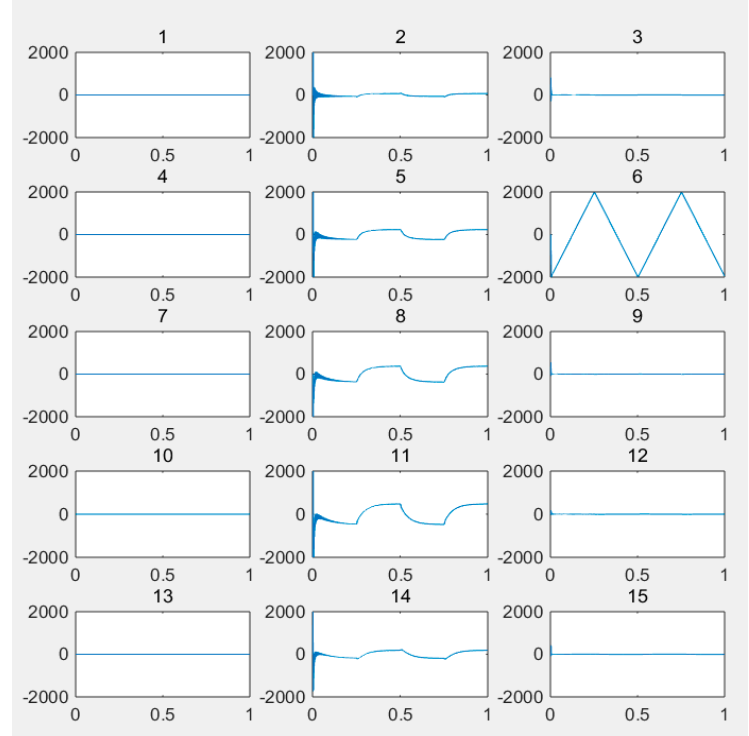
Figure 10. Location estimation of triangular force ( Q w = 1 × 10 − 8 , σ = 1 × 10 − 16 ) .